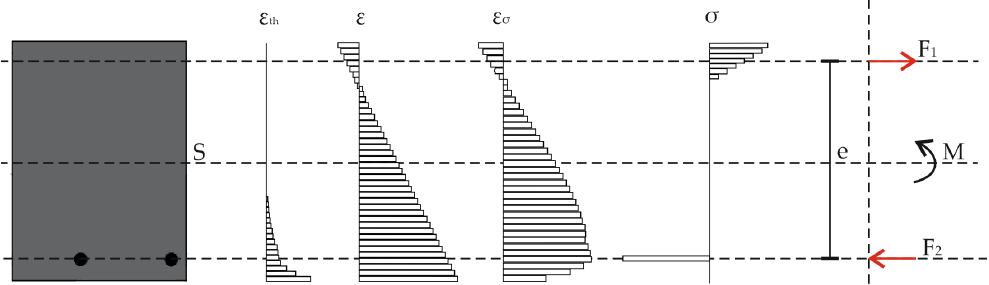
Figure 5. Stresses and strains in case of fire and pair of forces used to determine the flexural moment for a cross-section of the solid slab with the following abbreviations: ε th —thermal expansion, ε —total strain, ε σ —stress-generating strain, σ —stress, S—center of gravity line, F 1 —compression force, F 2 —tension force, e—distance of forces, and M—flexural moment.